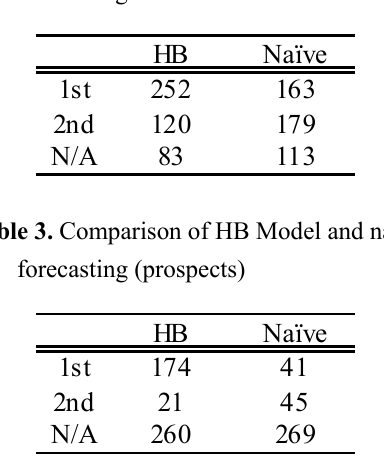
Table 2. Comparison of HB Model and naïve